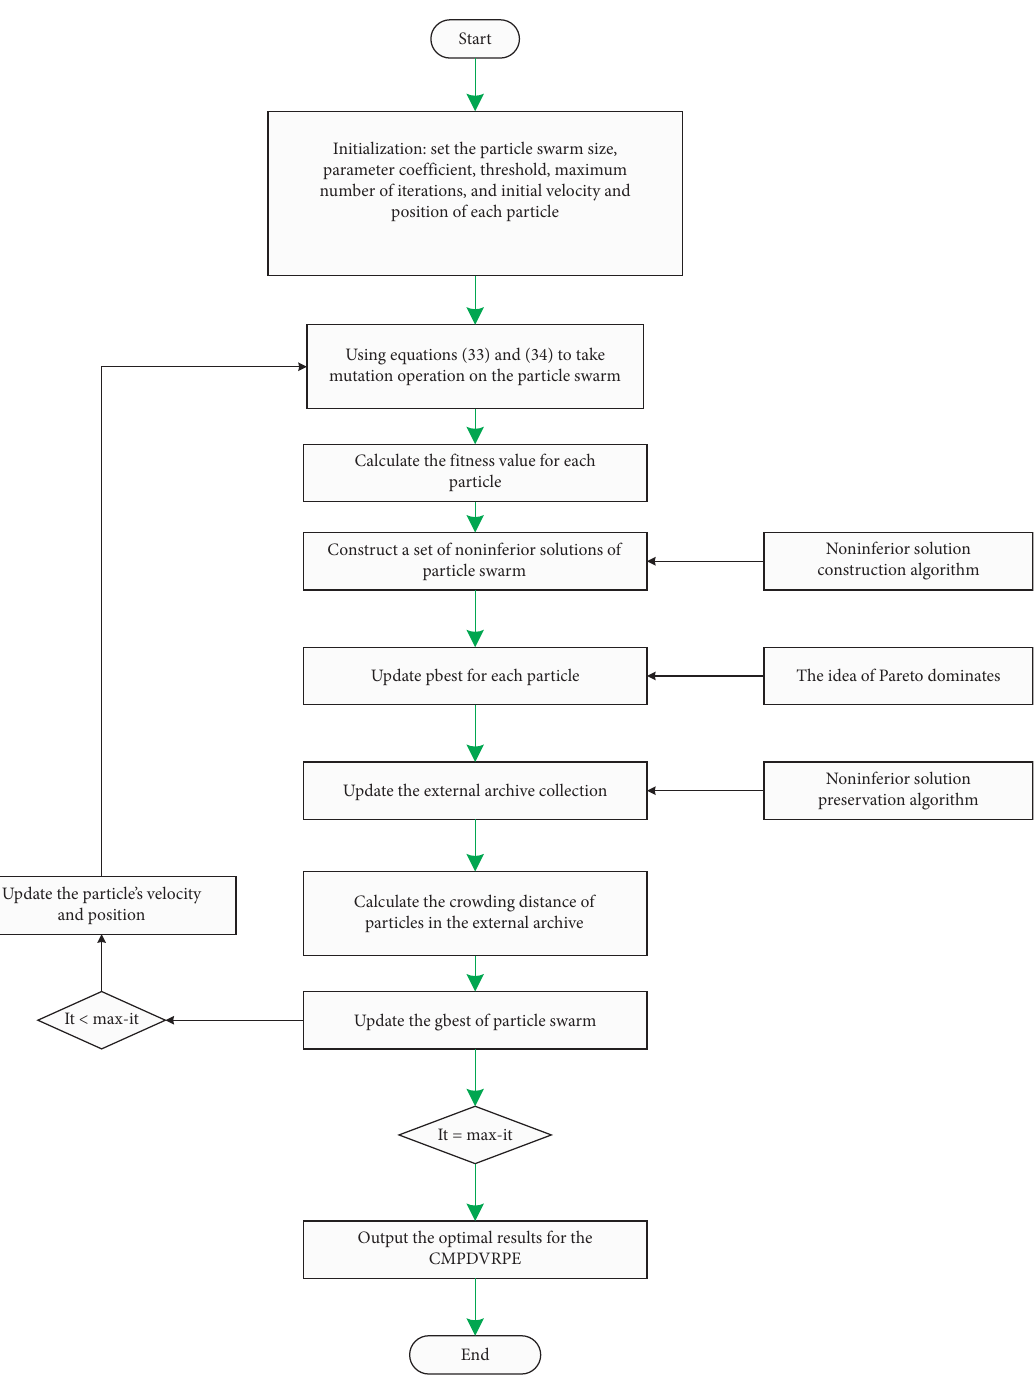
Figure 3: Flowchart of the IMOPSO